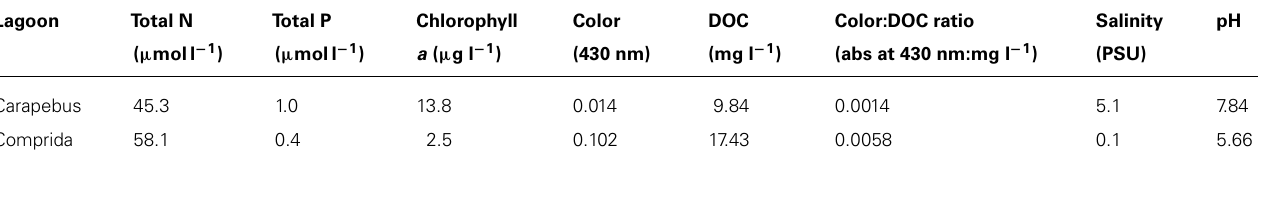
Table 1 | Nutrients, chlorophyll a , color, DOC, Color:DOC ratio, salinity (PSU – practical salinity unity), and pH in surface waters of Carapebus and Comprida coastal lagoons used in experimental microcosms.Values are means and units of each variable are described below. Lagoon Total